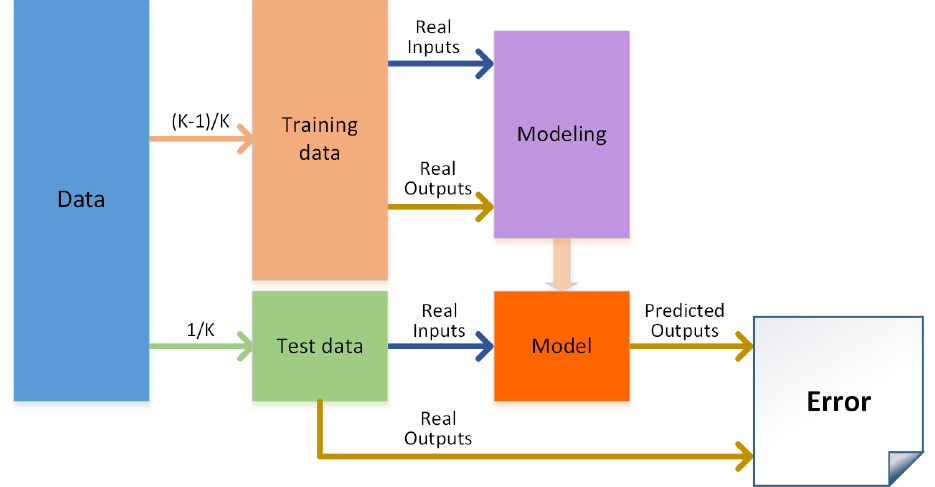
Figure 5. Modeling